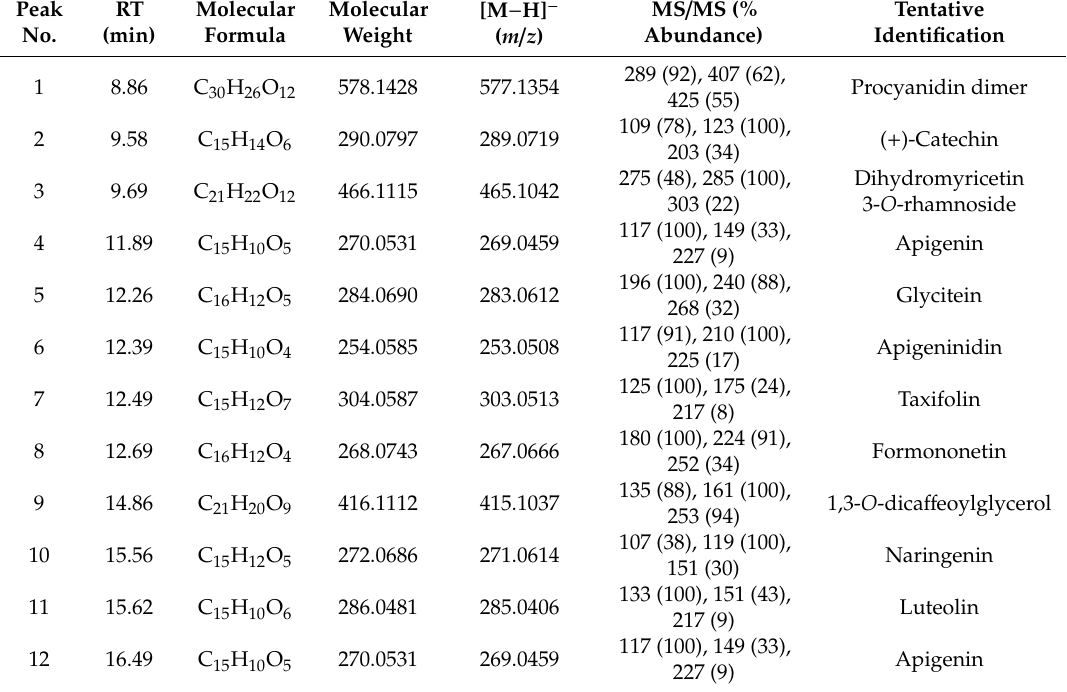
Table 2. Phenolic compounds identified in the ethanol extracts of DSOR 11 by UHPLC-Q-TOF-MS 2 . RT: Retention time.